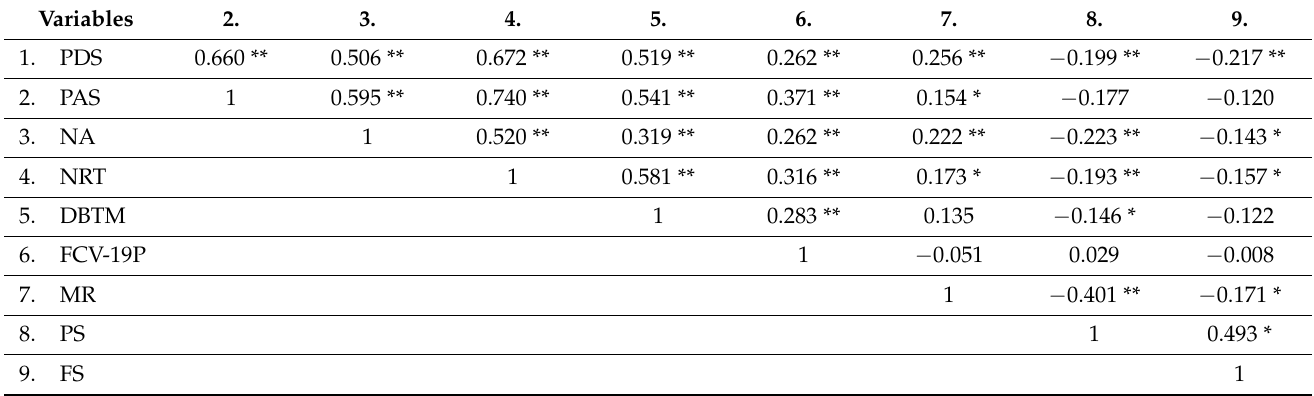
Table 2. Correlations of the Postpartum Depression Screening Scale (PDSS) and the Postpartum Anxious Screening Scale (PASS) scores and Negative Affect (NA), Negative Repetitive Thinking (NRT), Fear of COVID-19 in Postpartum period (FCV-19P), Dysfunctional Beliefs Towards Motherhood (DBTM), marital relationship (MR), and perception of partner’s support (PS) and family support (FS) for Group